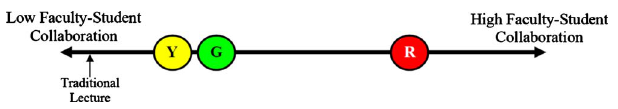
FIG. 2. (cid:1) Color (cid:2) A Continuum of a set of norms along the dimen- sion of faculty-student collaboration.